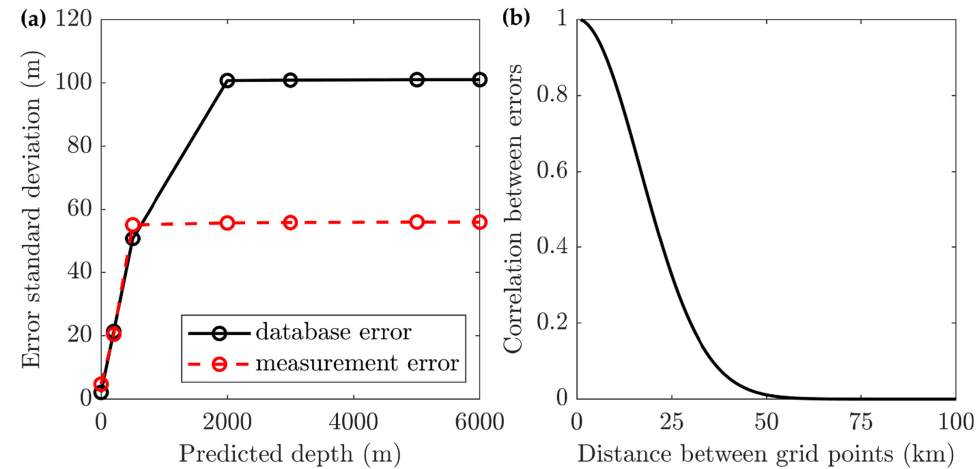
Figure A1. Maximum-likelihood estimated model of bathymetry uncertainty. ( a ) The model for the standard deviation of the error of the bathymetry database’s predicted value at a grid point given the predicted value (solid line), and the model for the standard deviation of the error of a measured value of water column depth given the measured value (dashed red line). ( b ) The model for the correlation between the errors in predicted values at two grid points given the distance between the two grid points. The inferred bathymetry correlation length is 16.7 km.